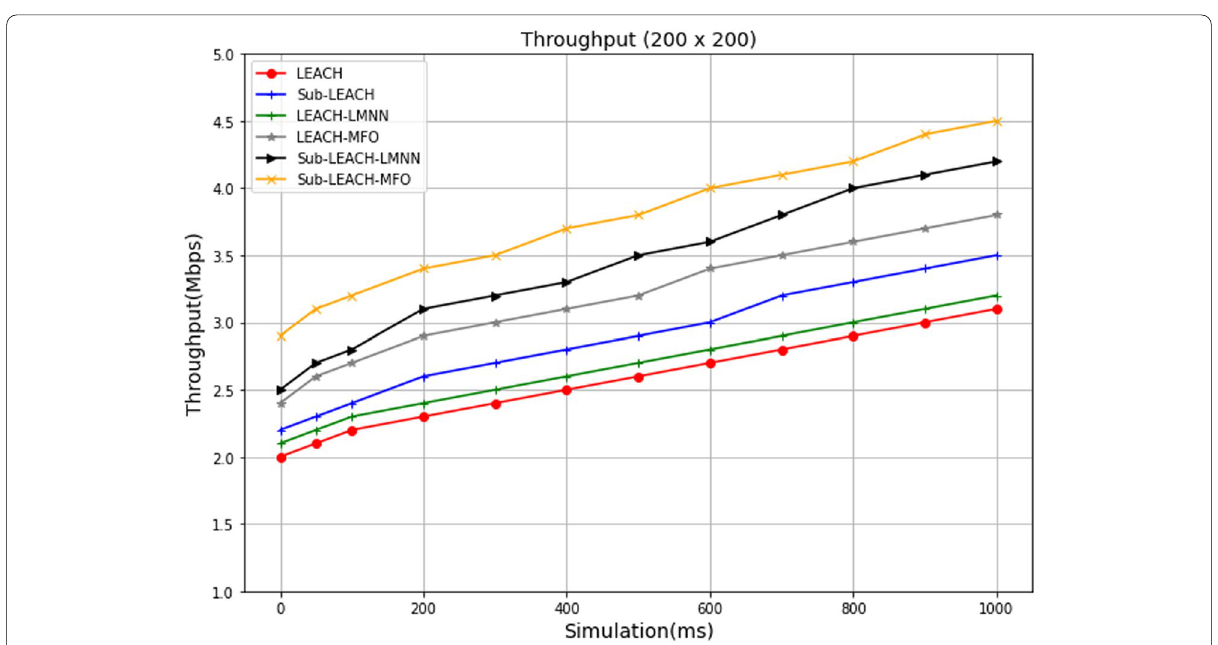
Fig. 16 Graphical representation of throughput analysis for